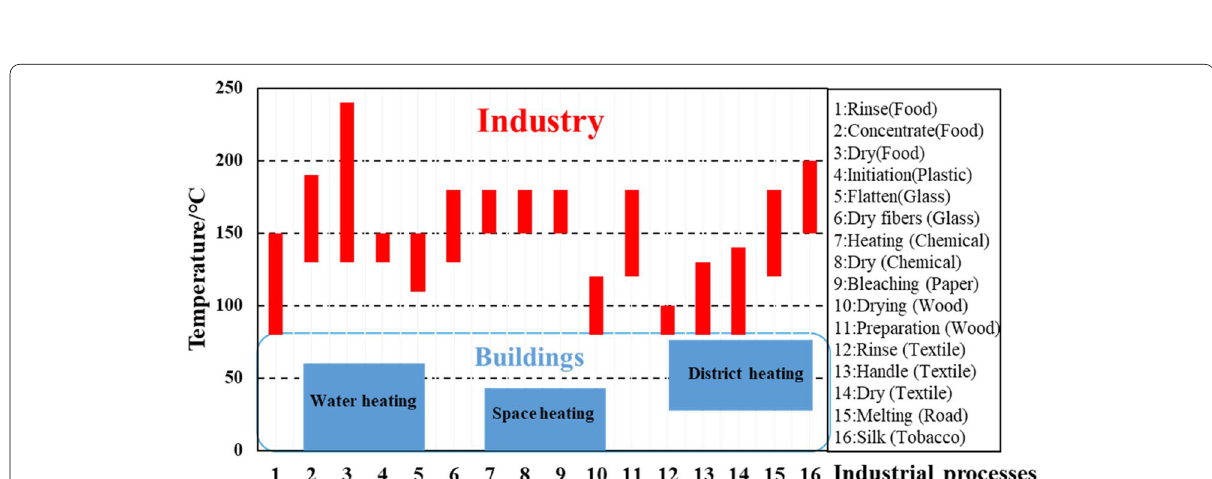
Fig. 5 The temperature range of heating demands in buildings and different industrial